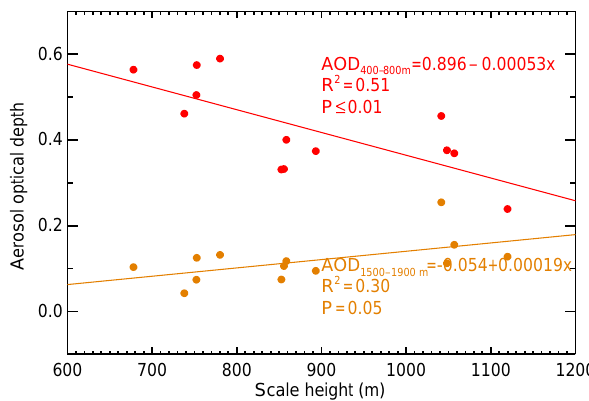
Figure 7. AOD in the lower PBL (AOD 400–800m ) and in the up- per PBL (AOD 1500–1900m ) as a function of aerosol scale height. Linear-fit equations, coefficients of determination, and p values are